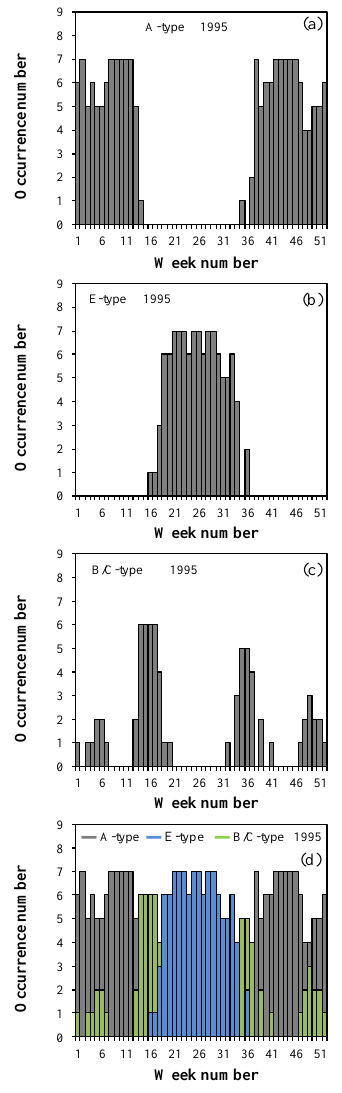
Figure 4. Histograms of the occurrences of the F-layer pattern types over the year 1995. The ordinate axis in each panel displays the oc- currence number of the pattern type, and the abscissa shows the nights divided into weeks. Seasonal behaviours are exhibited. In (a) the A-type pattern occurs during weeks 1–13 and 37–52, namely from October to the end of March including the northern winter pe- riod; in (b) the E-type pattern occurs during weeks 18–33, namely from May to mid-August including the northern summer period; in (c) the B- and C-type patterns (together as an identical F-layer pat- tern termed B/C-type) occur mainly during weeks 14–18 and 34–37, namely during the equinox periods, and this is, therefore, consid- ered the main season of the B/C-type pattern. Also in (c) the B/C- type pattern occurs erratically during weeks 3–7 and 47–52, namely from mid-January to mid-February and from mid-November to the end of December. These periods are considered as secondary sea- sons of the B/C-type pattern; in (d) the A-, E- and B/C-type patterns are shown